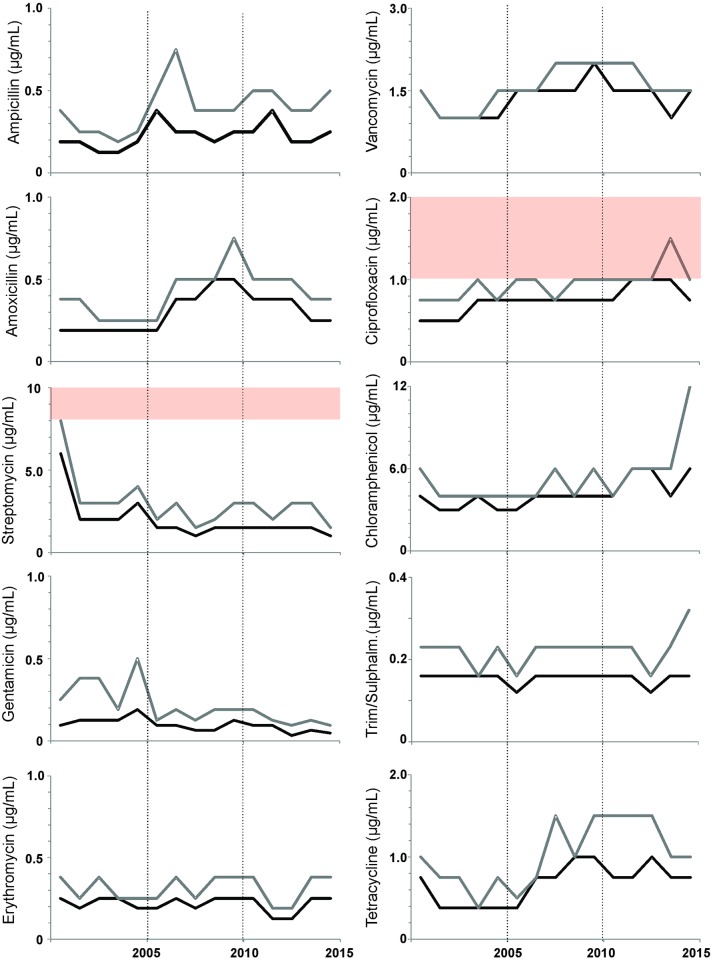
Yearly evolution of antimicrobial resistance in Belgian L. monocytogenes isolates (2000–2014).MIC50 and MIC90 values are indicated in black and grey, respectively. When in the figure range, clinical breakpoints are shown as broken lines, and zones of intermediate resistance as grey blocks.